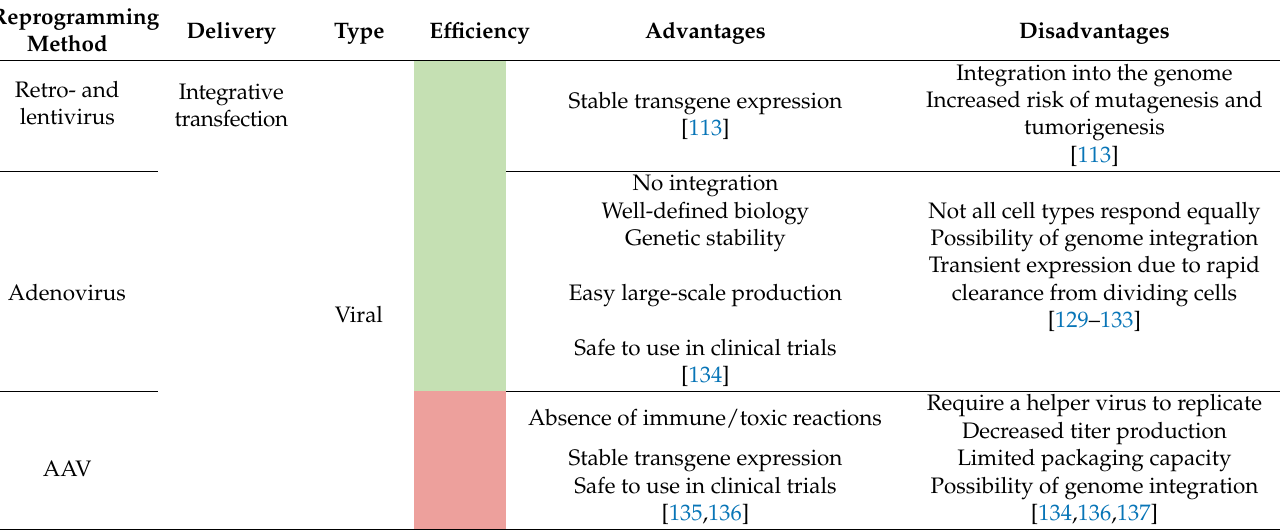
Table 2. Summary of cell reprogramming methods used for iPSC generation. Green—high